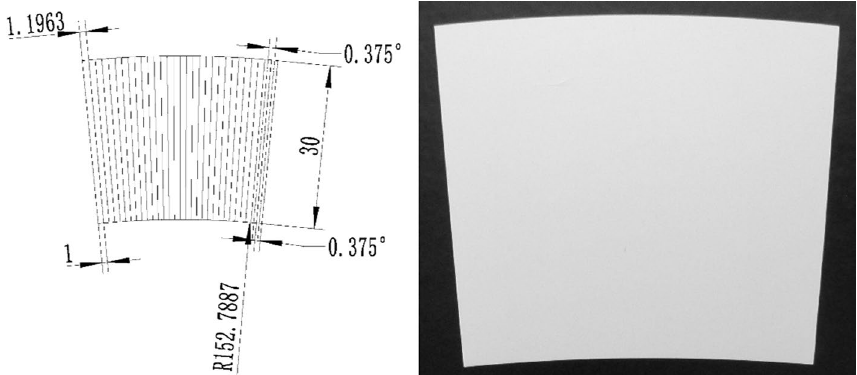
Fig. 7 (Left) Schematic and (right) photograph of a curved shape LYSO array used to minimize gaps between detector blocks [22]